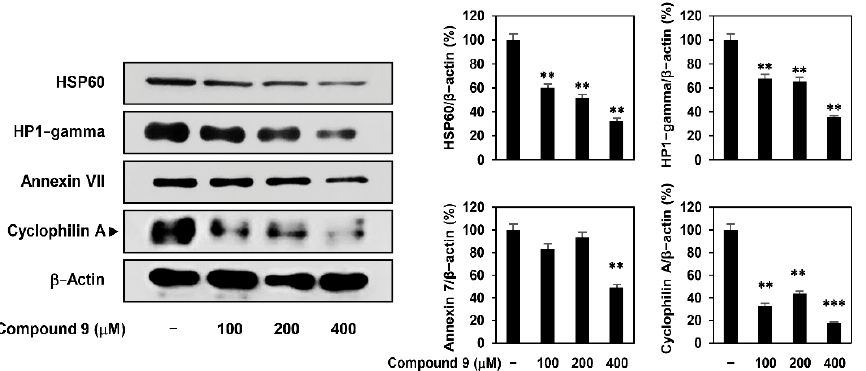
Figure 2. Validation of the identified protein spots. AGS cells were treated with compound 9 (100–400 µ M) for 24 h. Protein levels were detected by western blot analysis and further quantified by densitometry. The level of β -actin was used as an internal control. ** p < 0.01, *** p < 0.001 vs. the control.